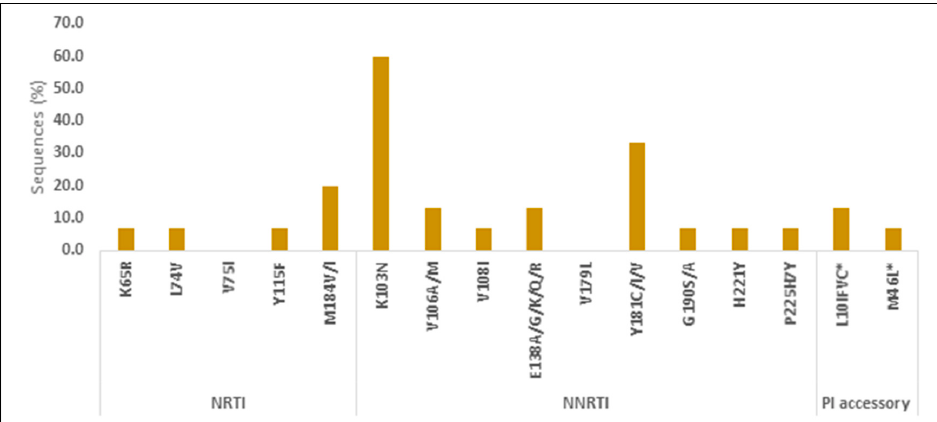
Figure 5. Types and prevalence of pre-ART drug resistance mutations in infants who never